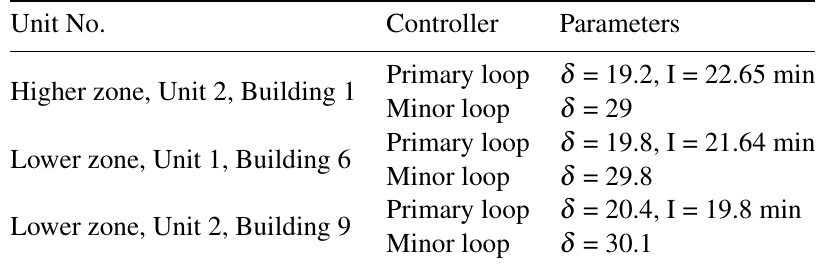
Table 5 Controller parameters.